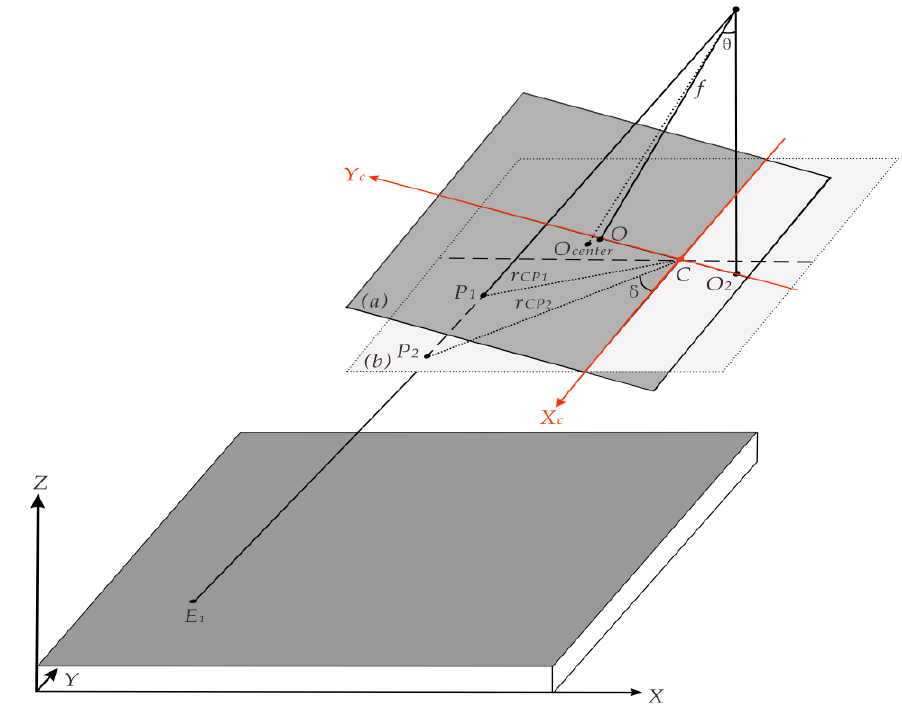
Figure 5. Selection of a shadow boundary point.